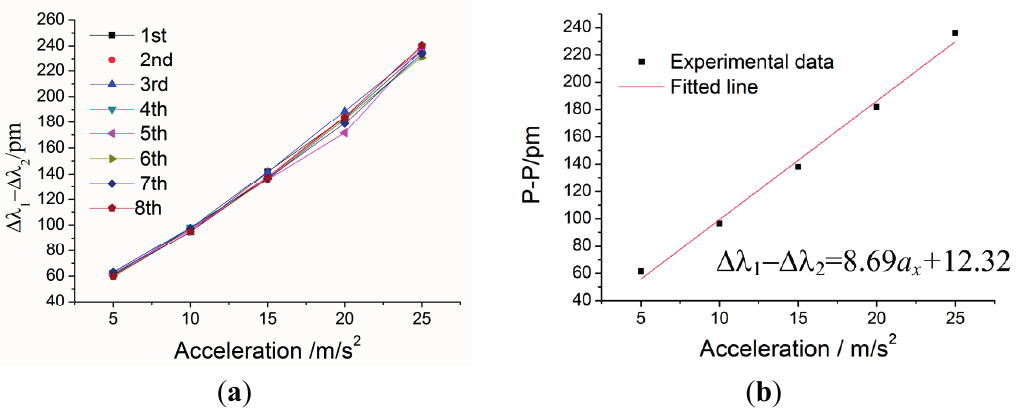
Figure 15. Difference value Δ λ 1 − Δ λ 2 versus acceleration a x under x -direction excitation with the acceleration frequency of 100 Hz. ( a ) Relation between Δ λ 1 − Δ λ 2 and acceleration a x within 5–25 m/s 2 . ( b ) The linear fitting